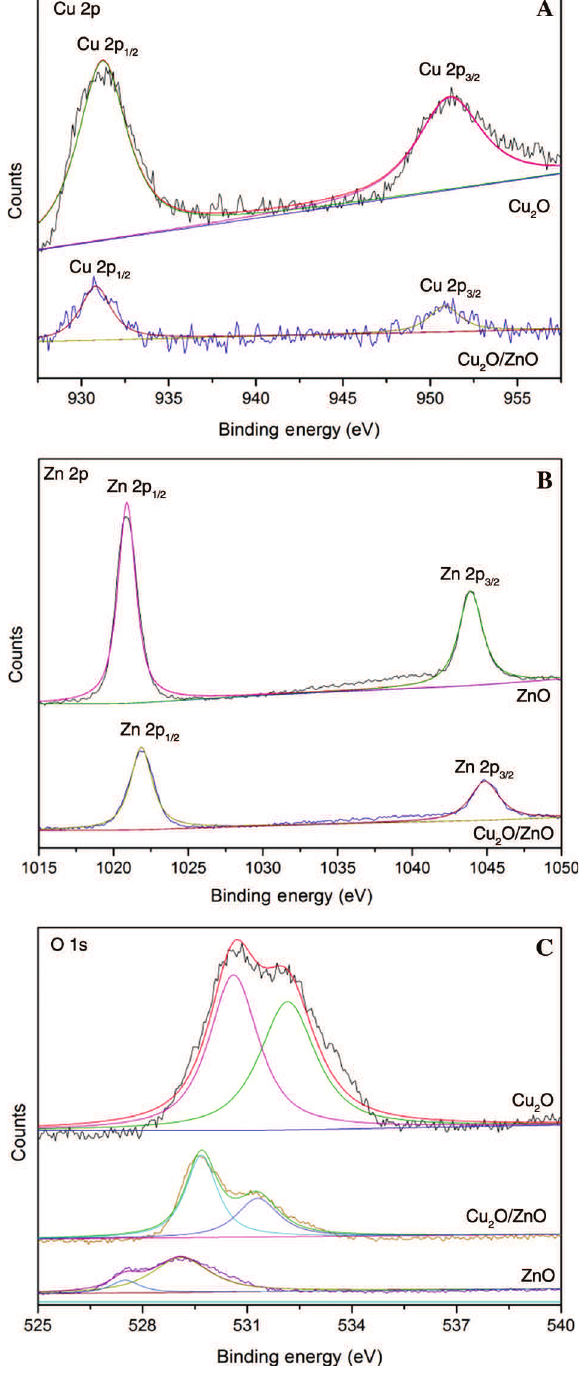
Figure 5: XPS images of Cu 2 O/ZnO (sample II), pure Cu 2 O, and pure ZnO and Gaussian deconvolution of Cu 2p (A), Zn 2p (B), O 1s (C). when the Cu 2 O concentration is 0.056 mol/l and the MO concentration is 50 mg/l, the photocatalytic degradation of the prepared Cu 2 O/ZnO catalyst is the best, and MO has been completely degraded at 180 min.